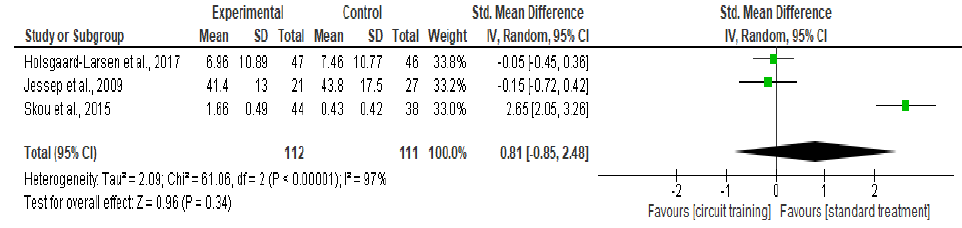
Figure 11. Forest plot analysis of the effect of CT on the activity of daily living [41–43].